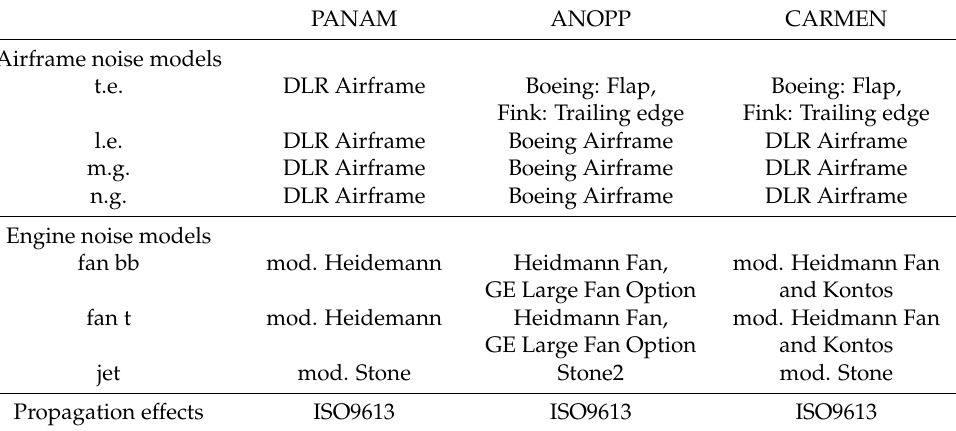
Table 1. Summary of simulation models used within PANAM, ANOPP, and CARMEN